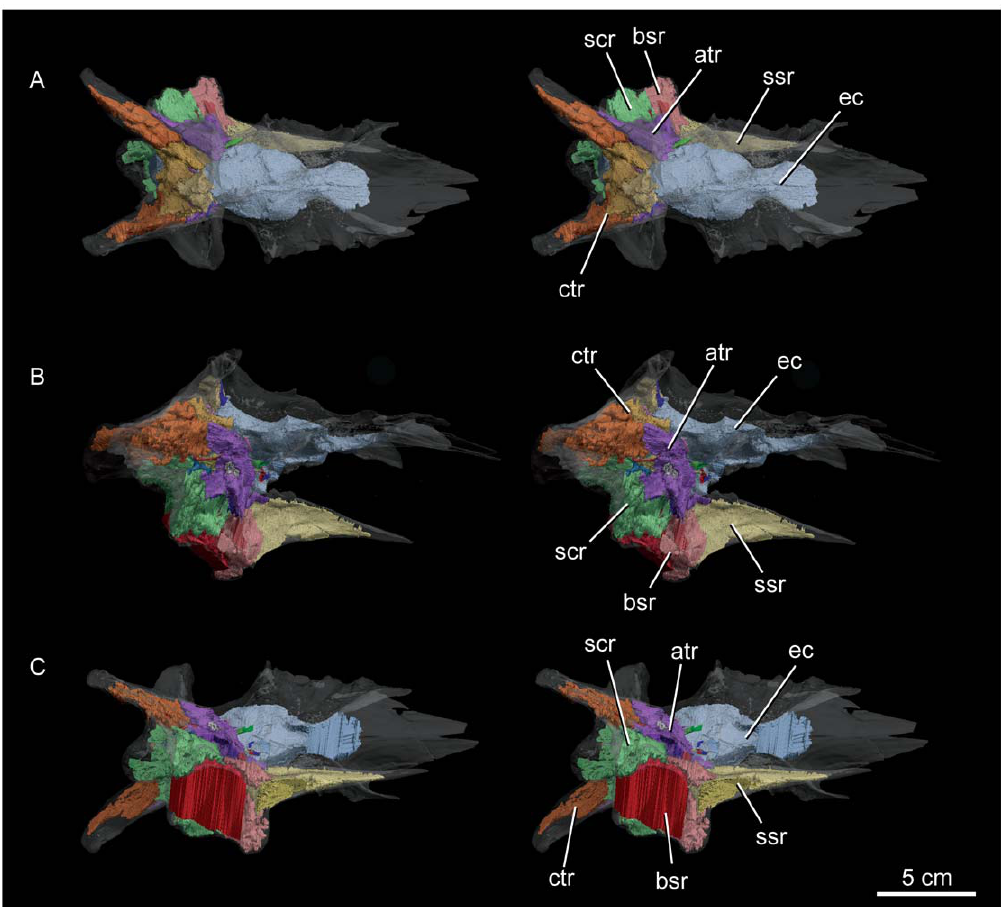
Figure 2. Stereopairs of the articulated braincase of Alioramusaltai (IGM 100/1844). Dorsal (A), right lateral (B), and ventral (C) views. The images are reconstructed from the CT data with the bones rendered transparent to show the internal structures examined in this study. atr, anterior tympanic recess; bsr, basisphenoid recess; ctr, caudal tympanic recess; ec, endocranial cavity; scr, subcondylar recess; ssr, subsellar recess.